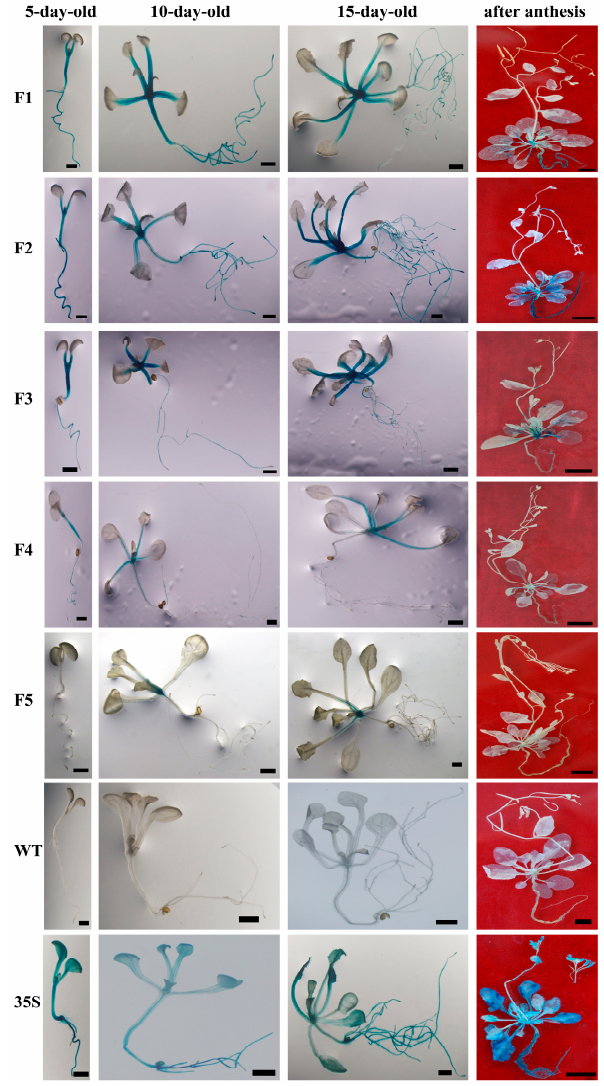
Figure 2. GUS staining of T 3 Arabidopsis. Bar = 1 mm, Bar = 1 cm (“after anthesis”). For each construct, three independent lines (more than 20 plantlets of each line) were GUS-stained; representative plants are shown.